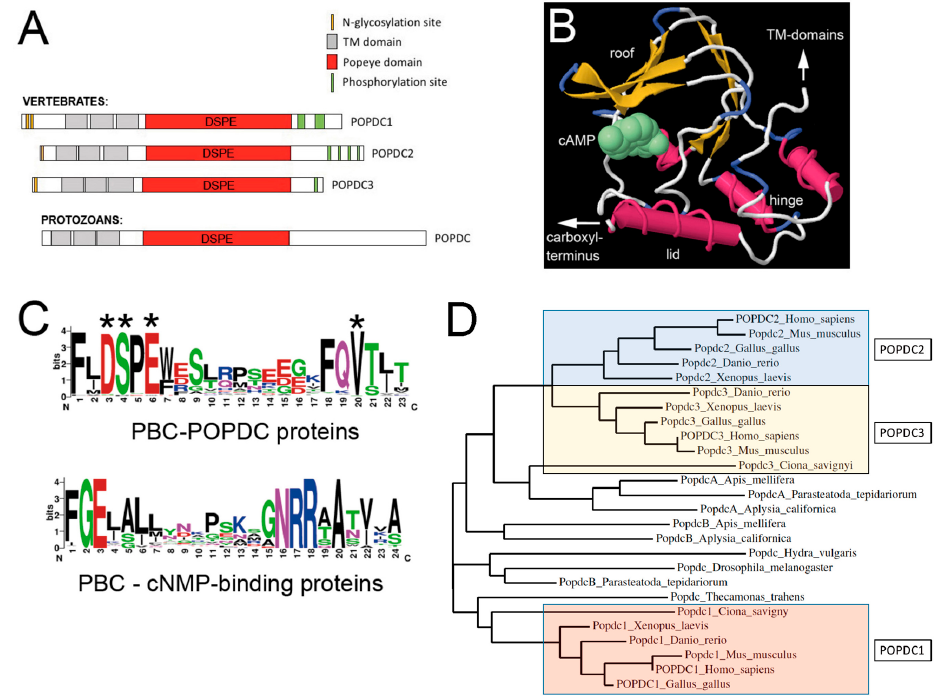
Figure 1. The Popeye domain containing protein family. ( A ) Graphic depiction of the domain structure of POPDC proteins. POPDC proteins consist of a short extracellular amino terminus, which is subject to N -glycosylation, followed by three transmembrane domains and the Popeye domain. The approximate location of the invariant DSPE motif, which is part of the phosphate-binding cassette (PBC), is indicated. The carboxy terminal part of the proteins is variable in size, differs between family members and contains a cluster of serine/threonine residues, which are subject to phosphorylation in response to β -adrenergic stimulation [16]. The structure of a protozoan POPDC protein has an overall identical structure, suggesting an ancient origin of the POPDC protein family. ( B ) Structural model of the Popeye domain of POPDC1. The 3D model depicted here was generated using the First Glance in Jmol website [18]. The structural elements (roof, hinge and lid) of the Popeye domain have been identified based on their similar location in other cAMP-binding domains [6]. ( C ) Comparison of the PBC of POPDC proteins and that of canonical cyclic nucleotide monophosphate (cNMP)-binding proteins. In POPDC proteins, cAMP-binding involves the ultra-conserved sequence motifs DSPE and FQVT. Experimental evidence for the involvement in cAMP-binding has been obtained for D 200 , S 201 , E 203 and V 217 (asterisks). The canonical cAMP-binding cassette strongly diverges from the one present in POPDC proteins. Sequence data utilized for the generation of the logo for the Popeye domain were retrieved from the PFAM entry of the Popeye domain [19]. For the protein sequences of non-POPDC cAMP binding proteins, the data were downloaded from Prosite (PS00889; CNMP_BINDING_2) [20,21]. ( D ) A phylogenetic tree of vertebrate and invertebrate POPDC protein sequences. The vertebrate Popdc proteins cluster into three groups: POPDC1, POPDC2 and POPDC3. The POPDC1 and POPDC3 proteins of the urochordate Ciona savignyi appear to be orthologous to their respective vertebrate counterparts, supporting a model of two gene duplication events during chordate and vertebrate evolution, respectively. Popdc proteins in other invertebrates do show similarity to either Popdc1 or Popdc2/3, and thus, protein ancestry cannot be easily deduced from this analysis. The tree was generated with the help of the Phylogeny online platform